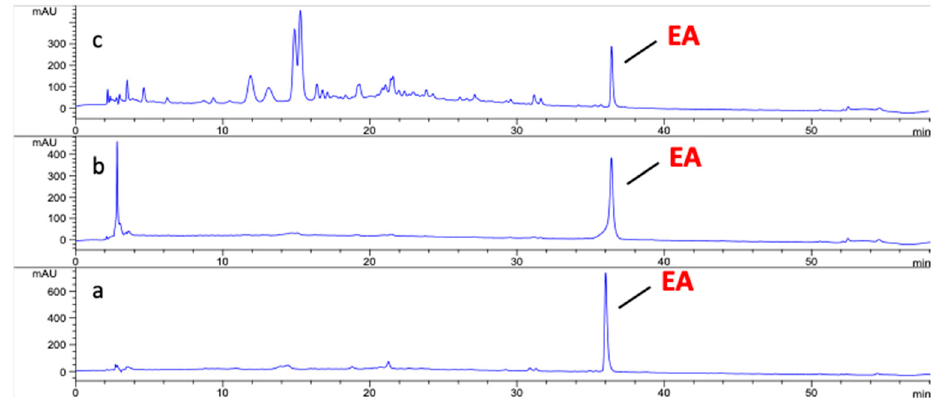
Figure 2. HPLC elution profile of the extracts of Saccharomyces cerevisiae fermented pomegranate wastes obtained using DMSO ( a ) (diluted 1:20), ethanol ( b ) (diluted 1:5), and water ( c ) (diluted 1:5) at a solid to solvent ratio of 1:10 g/mL.